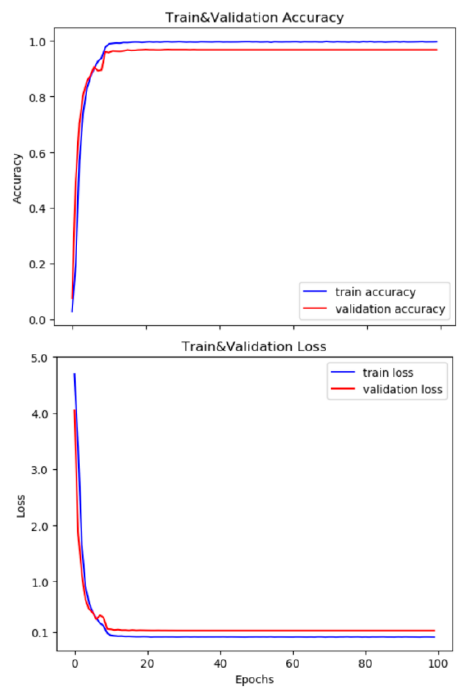
Figure 4. Accuracy and loss curves of CK+ dataset during training.